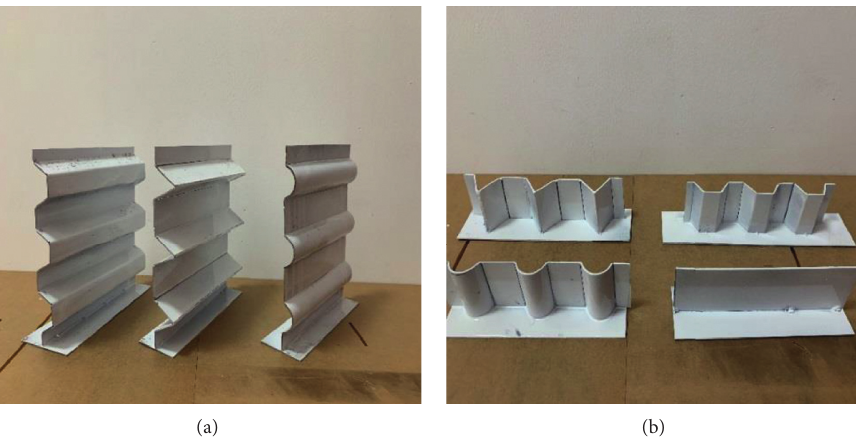
Figure 2: Corrugated steel plate test pieces used for (a) reflection testing with transverse corrugations shaped as trapezoidal ( F triangular ( F S , middle), and half-cylindrical ( F Y , right) and for (b) diffraction testing with vertical corrugations shaped as triangular ( R S , upper left), half-cylindrical ( R Y , lower left), trapezoidal ( R T , upper right), and noncorrugated ( R C , lower